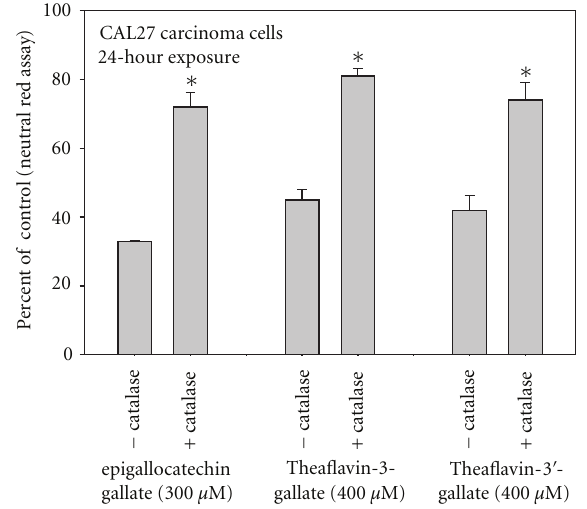
Figure 5: Comparative toxicities of epigallocatechin gallate (EGCG), theaflavin-3-digallate, and theaflavin-3 (cid:2) -gallate extract towards human oral HSC-2 carcinoma cells in the absence and presence of exogenously added catalase. Cell proliferation was quantified with the neutral red assay, a cell viability assay. Data are presented as the mean percent of control ± S.E.M. Data for EGCG are from Weisburg et al. [12] and for the black tea theaflavin monogallates are from Babich et al.